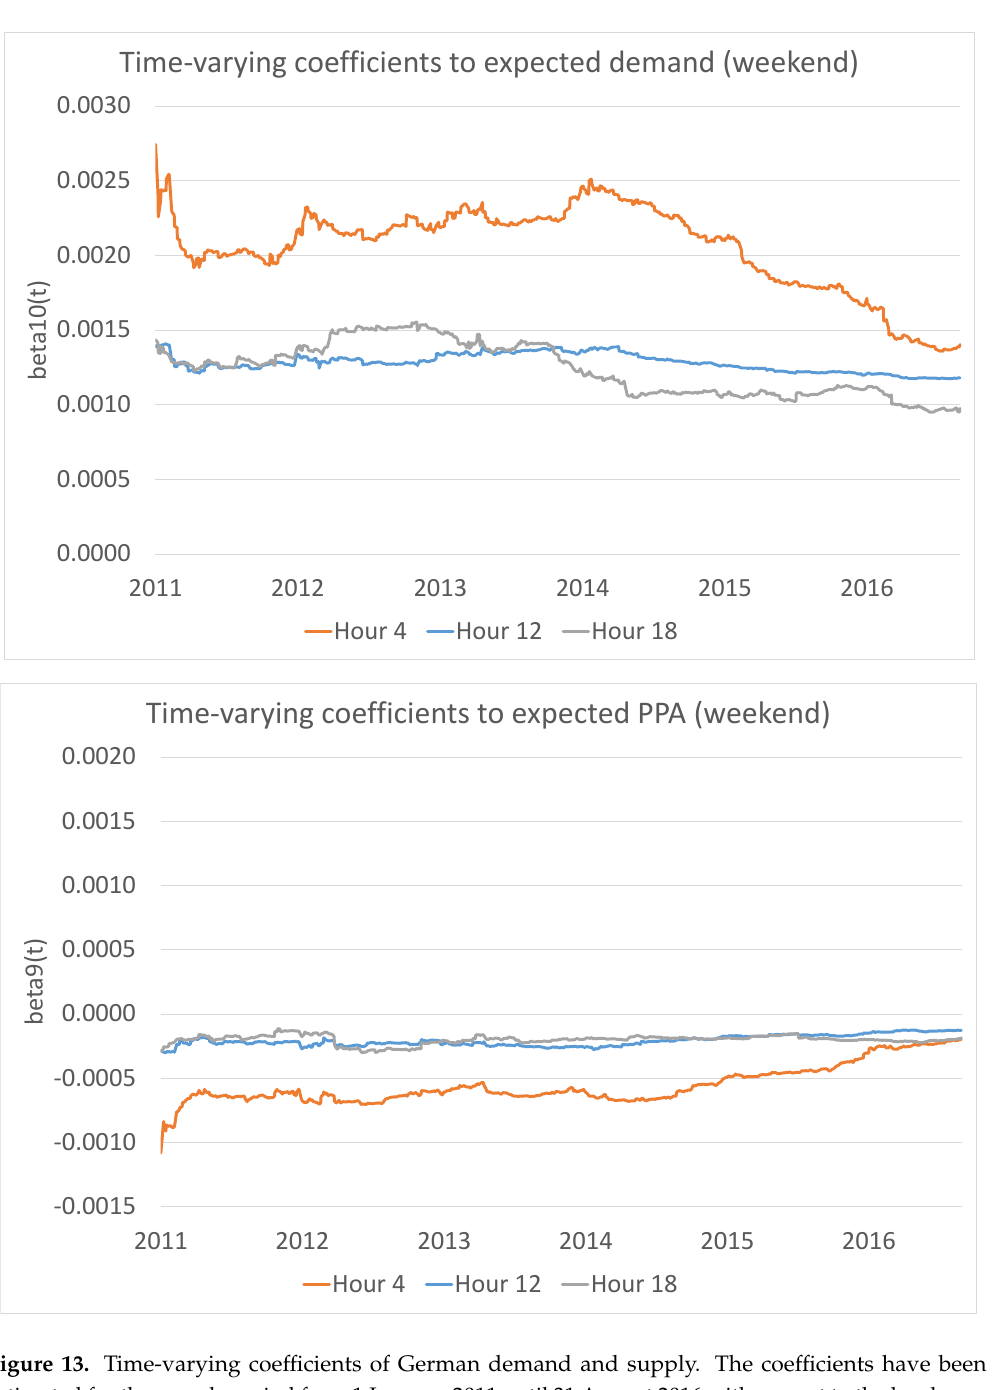
Figure 13. Time-varying coefficients of German demand and supply. The coefficients have been estimated for the sample period from 1 January 2011 until 31 August 2016 with respect to the key hours H4, H12 and H18 on weekend